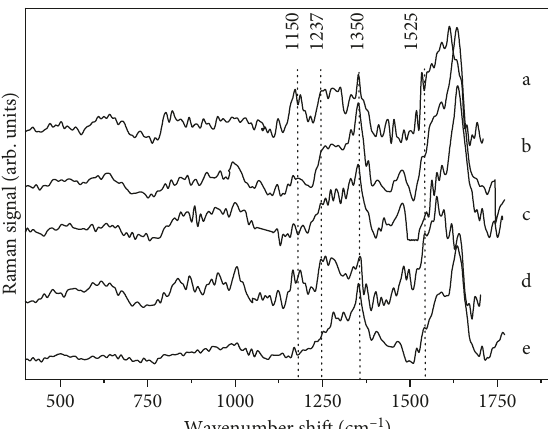
Figure 4: Representative SERS spectra from noncommercial EVOO samples from different sites (a) Triggiano, (b) Avella, (c) Chiaromonte, (d) Bellona, and (e) Alberobello in 500–1750cm